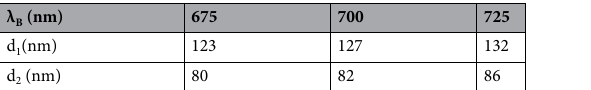
Table 3. The 1D-PC structural parameters. (MgF 2 /MoO 3 ) N 1D-PC system thicknesses d 1 and d 2 for λ B = 675, 700, 725